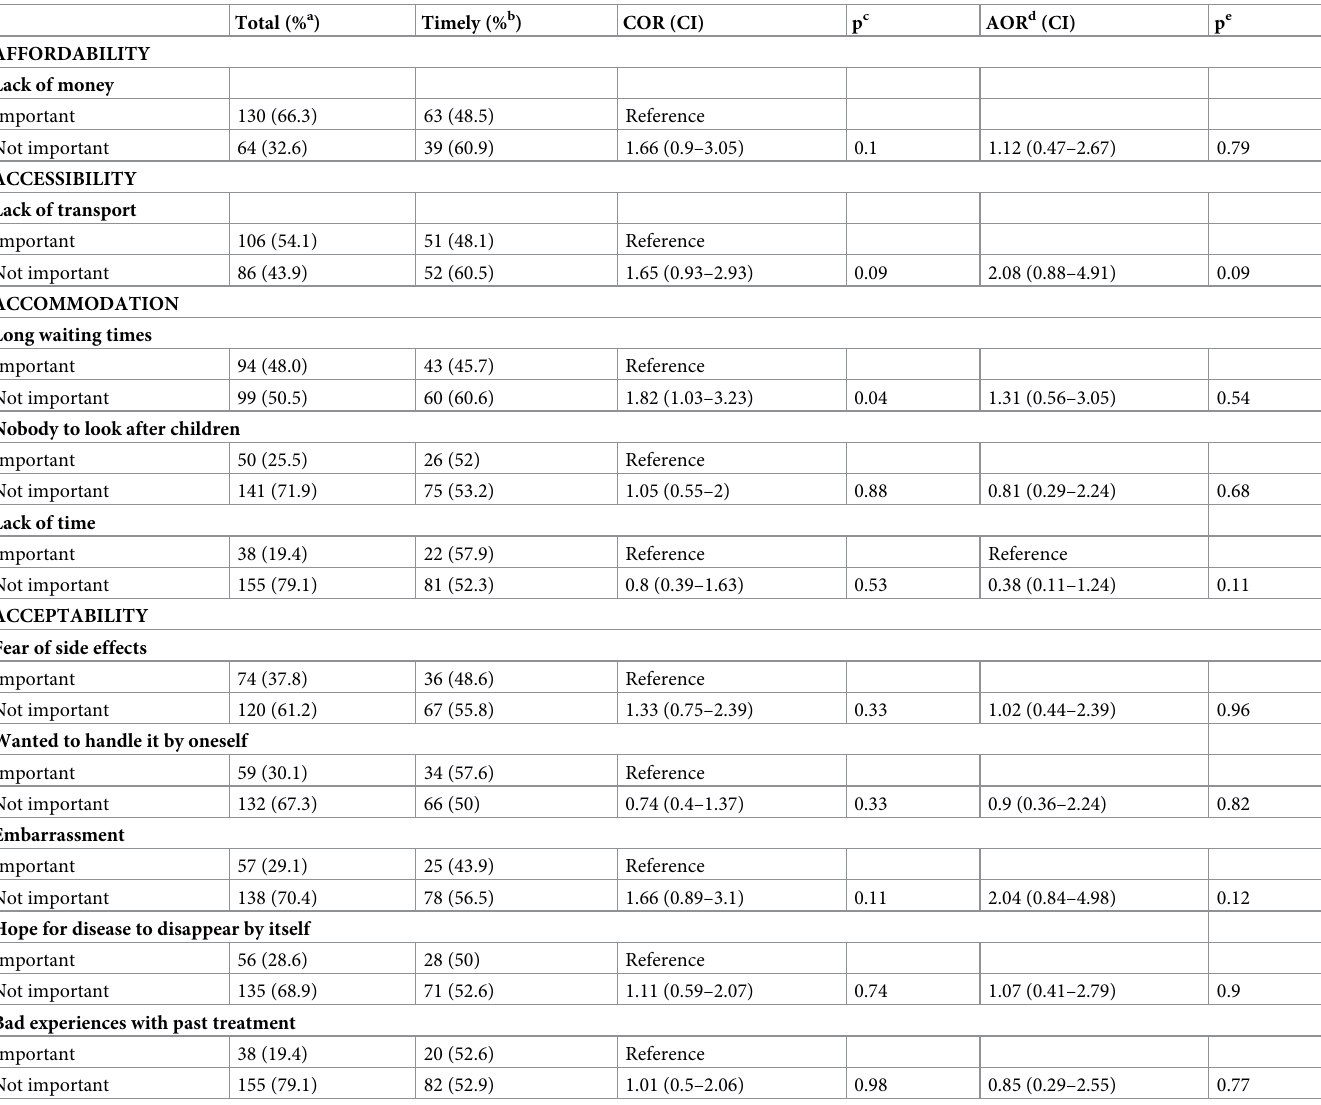
Table 4. Simple and multivariate regression modell of the influence of patients´ perceived barriers on timely systemic treatment initiation for breast cancer